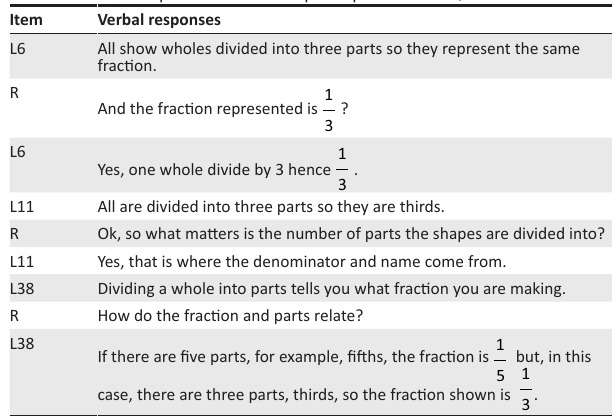
Table 5 contains selected verbatim responses from L6, L11, L15 and L17 during the interview. Interviewees responded Question 1.1.